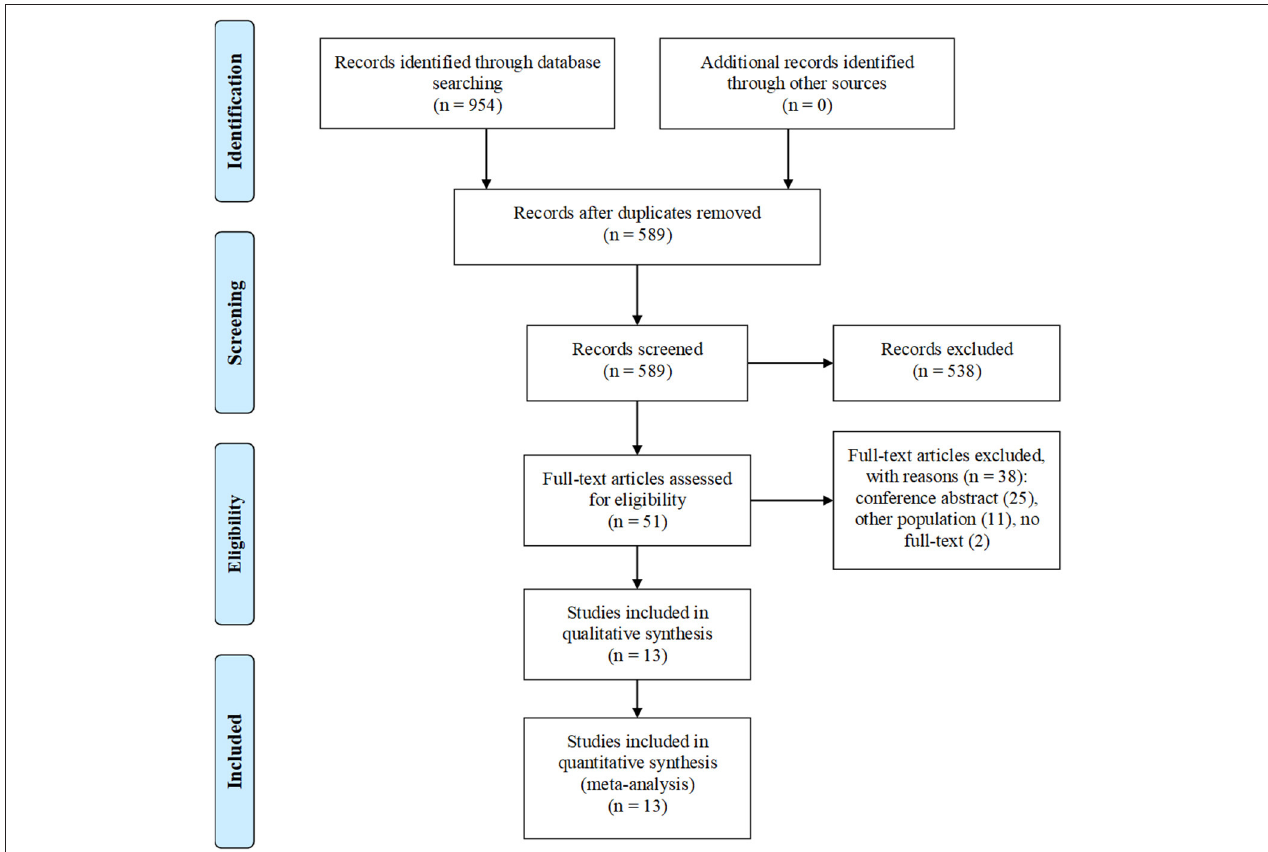
FIGURE 1 | Flow diagram of study